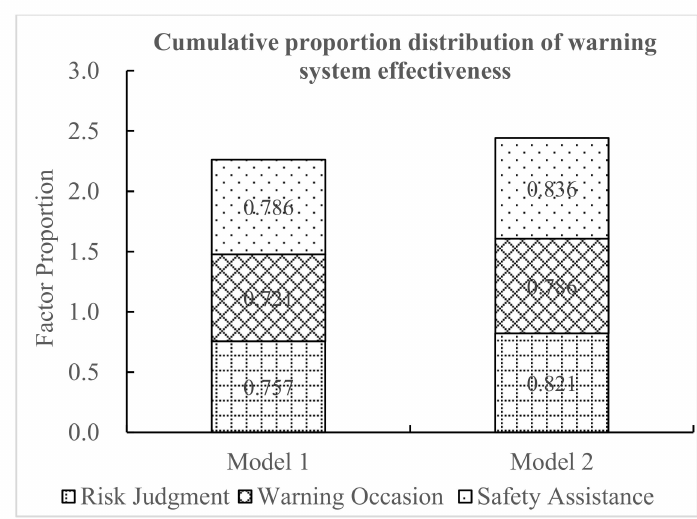
Figure 16. Cumulative proportion distribution of warning system